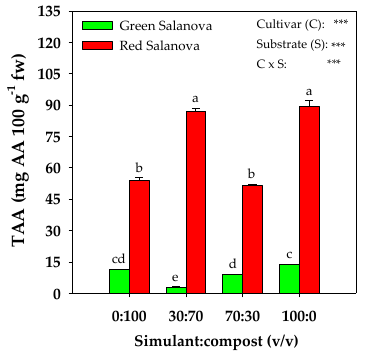
Figure 3. Total ascorbic acid (TAA) content of green and red Salanova lettuce, as influenced by substrate mixture (four different rates of MMS-1 simulant:compost v:v). Different letters above bars indicate significant mean differences according to Duncan’s multiple range tests ( P ≤ 0.05). Vertical bars indicate ± SE of means. *** Significant at P ≤ 0.001.